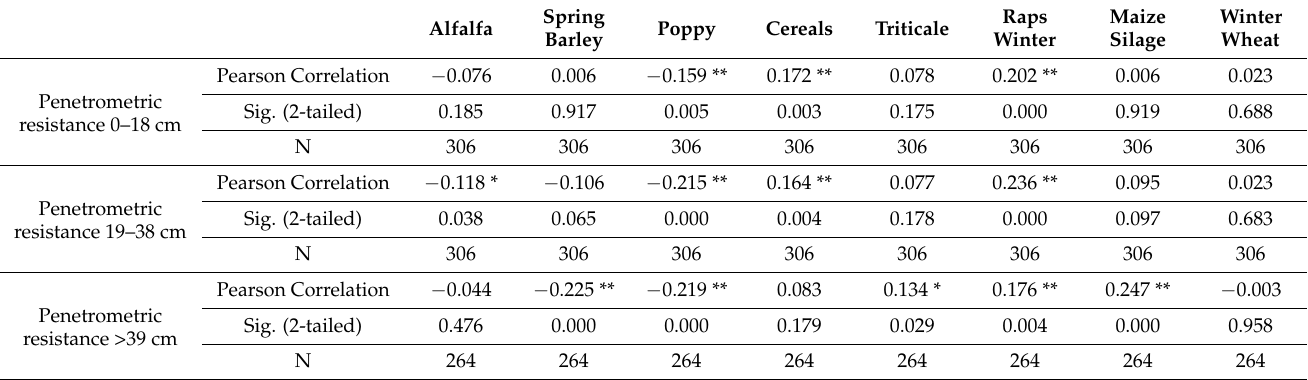
Table A14. Correlation analysis of penetrometric resistance according to the frequency of crops on the